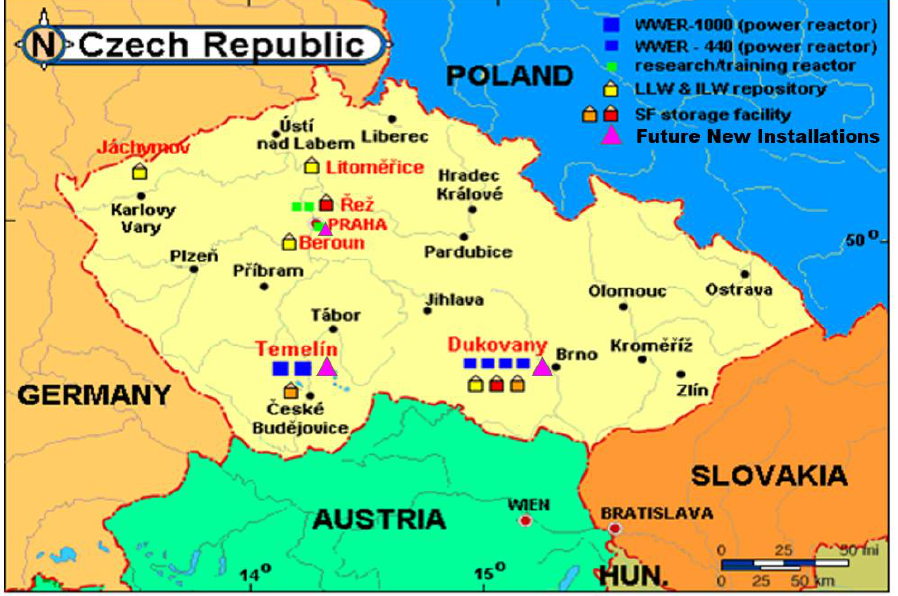
Figure 2 . Czech Republic nuclear facilities map . Figure 2. Czech Republic nuclear facilities